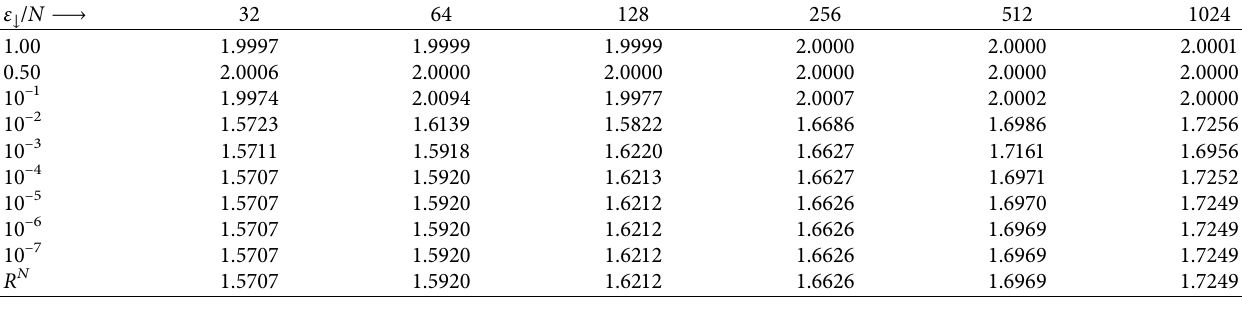
Table 2: Result of Example 1 (rate of convergence) for δ � η � 0.5 ∗ ε .